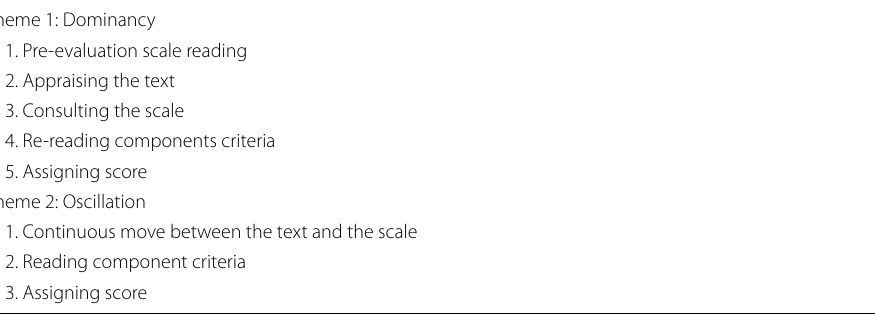
Table 2 Raters’ interactions with components of analytic scale Theme 1: